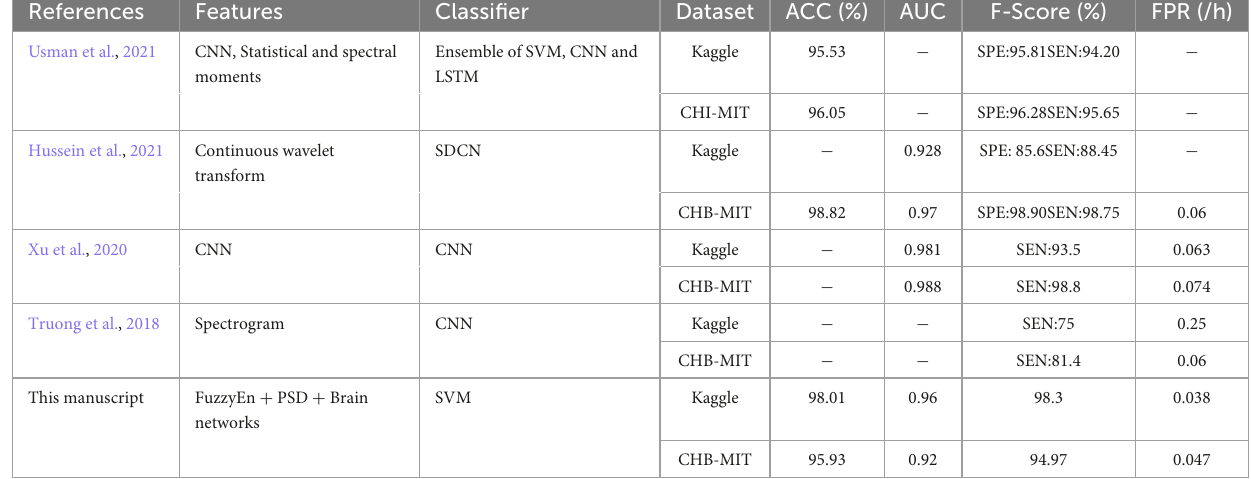
TABLE 8 The comparison results between the proposed method and other existing state-of-the-art